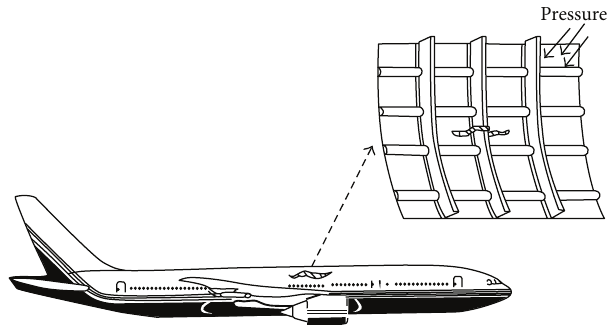
Figure 1: Fuselage panel with discrete source damage